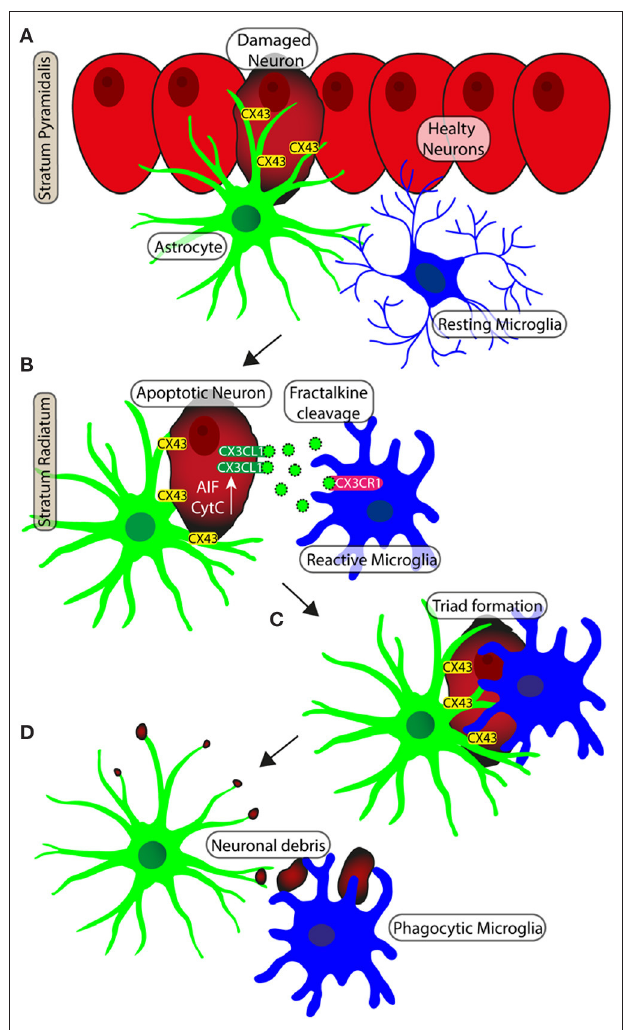
FIGURE 4 | Schematic representation of neuron-astrocytes-microglia interplay during neurodegeneration. (A) Apoptotic neurons of pyramidal layer show diffuse cytoplasmic staining of CytC or AIF. Gap junctions (Connexine 43) mediate the recruitment of astrocytes on neurons. (B) The apoptotic neuron is detached from the Pyramidal layer to becoming an ectopic pyramidal neuron. CX3CL1 (fraktalkine) is released by the ectopic neuron and the astrocyte branches take close contact with the neuron. (C) Microglia are recruited and astrocytes branches infiltrate the body of the damaged neuron. (D) The damaged neuron is bisected and disgregated in cell debris. Phagocytic microglia mediate the clearance of cell